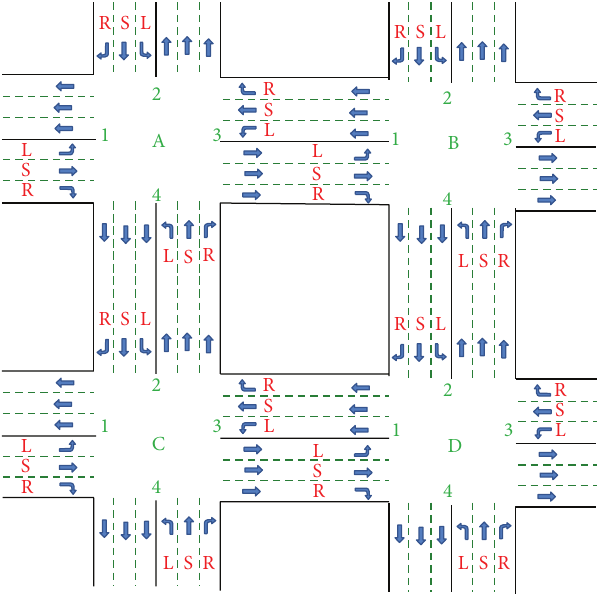
Figure 2: The four intersections and road notations. L: turn left; S: straight; and R: turn right.